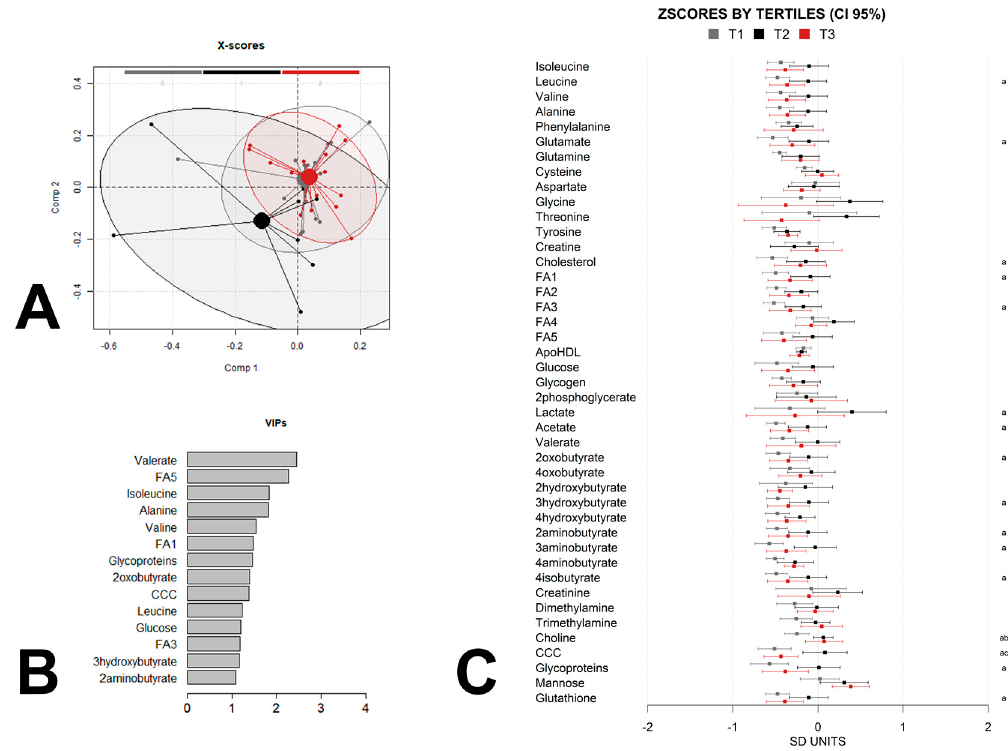
Figure 3. PLSDA analysis and z-scores of newborn metabolome at 6 months of age, by maternal-weight-gain tertile. ( A ) Score plot with 95% confidence ellipse of the PLS-DA analysis of the metabolome, adjusted for child sex, child weight at birth, maternal obesity, maternal diabetes, and maternal adherence to the Mediterranean diet for the discrimination between tertiles (tertile 1 (T1) gray, tertile 2 (T2) black, tertile 3 (T3) red). Cross-validation parameters: RMSECV 0.304, R2CV: 0.582; ROC Curve AUC: 0.96. ( B ) Metabolites with PLS-DA VIP score higher than 1 for the same PLS-DA model of the metabolome. ( C ) The Z-scores and 95% confidence intervals of individual metabolites in offspring grouped by tertile. Metabolites with statistically significant pairwise differences between tertiles (adjusted p -value < 0.05) are labeled as “a” (tertile 1 vs. tertile 2), “b” (tertile 1 vs. tertile 3), and/or “c” (tertile 2 vs. tertile 3). Label keys are the same as those in Figure 1.